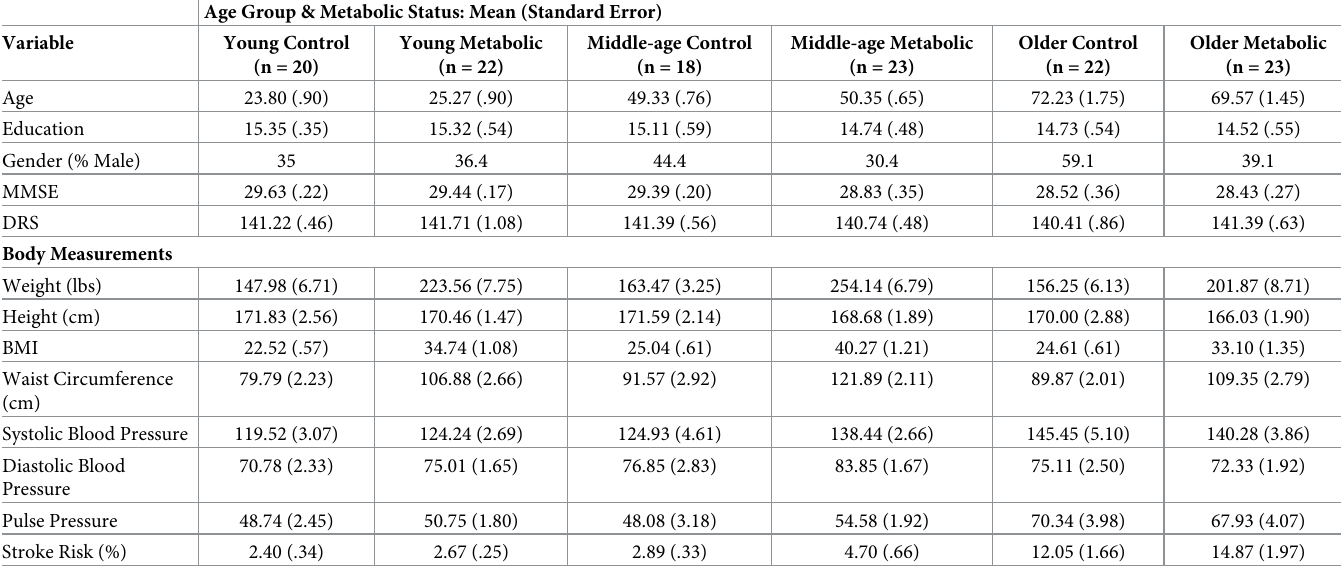
Table 1. Demographic characteristics of